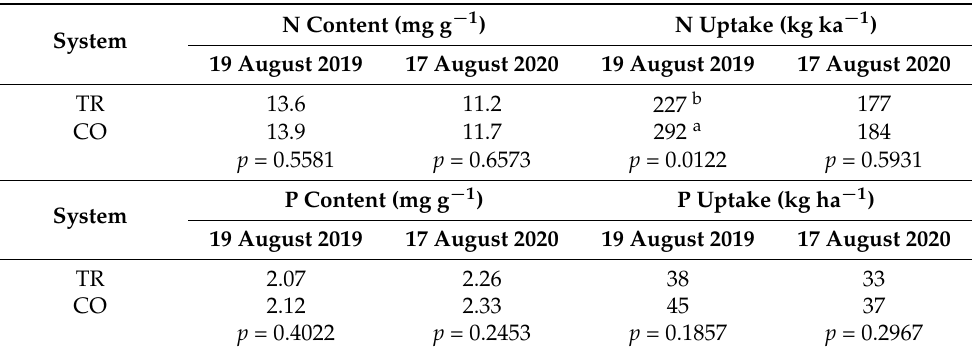
Table 5. N (mg g − 1 ) and P (mg g − 1 ) content, N and P uptake (kg ha − 1 ) for the TR (with CC) and CO (without CC) systems measured at the maize harvest time. Different letters are significantly different at p < 0.05 (Duncan